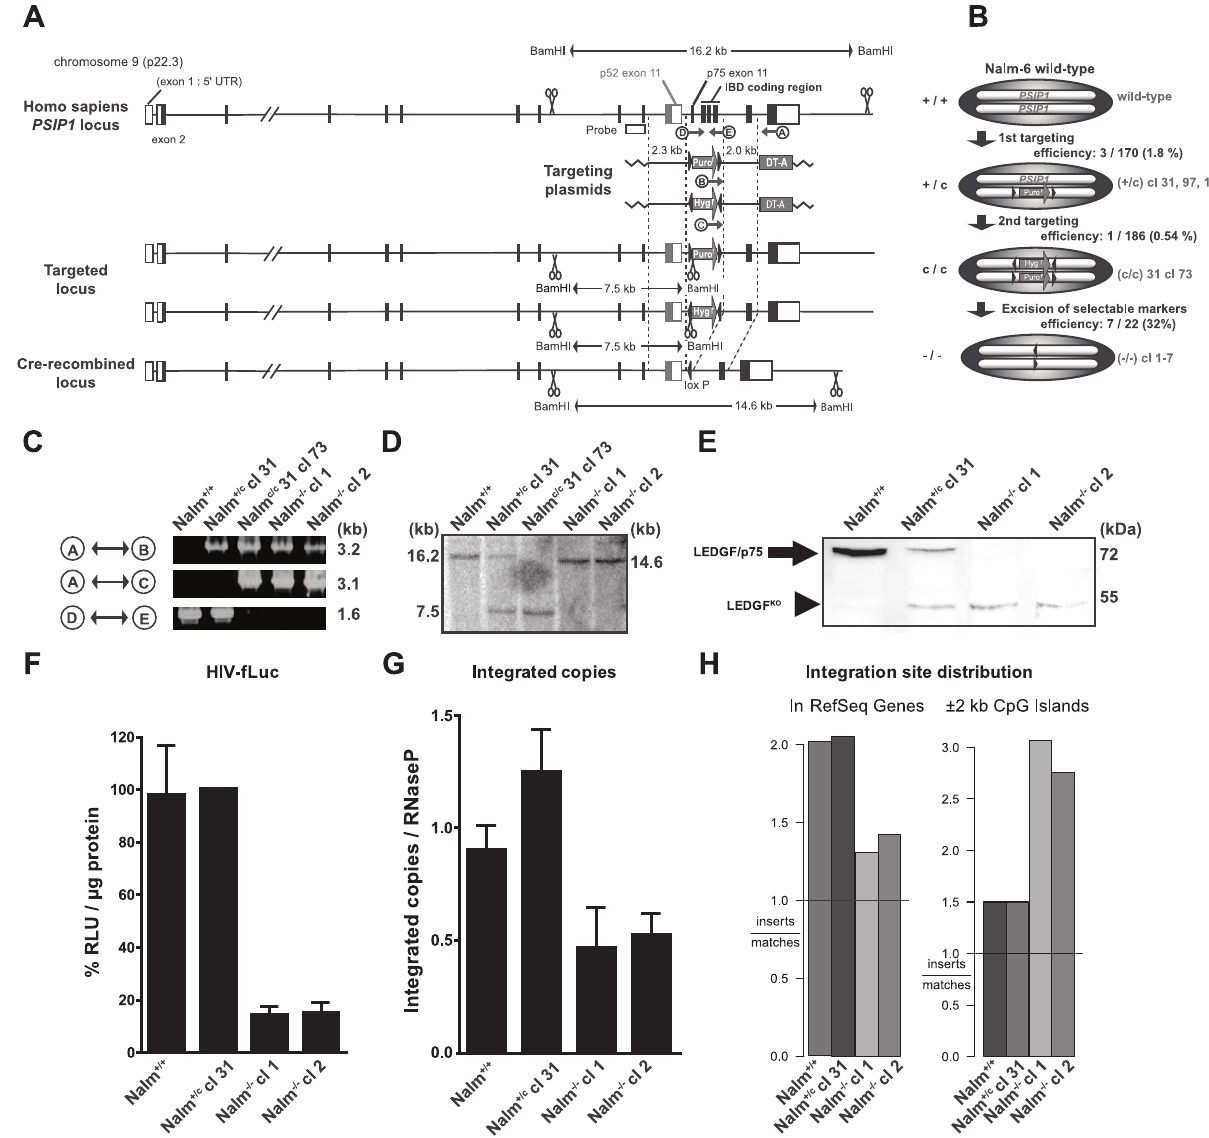
Figure 1. Generation and validation of human LEDGF/p75 KO cell line. (A) Scheme for PSIP1 gene targeting by homologous recombination. The 2.3 and 2.0 kb arm indicated on the targeting plasmids enable homologous recombination and harbor a puromycin (Puro r ) or hygromycin B resistance (Hyg r ) cassette (c) flanked by loxP sites (arrows). Exon 11 of p52 and p75 are indicated separately as well as the IBD coding region. BamHI restriction sites are indicated (scissors). DT-A denotes the gene encoding for Diphteria toxin A. (B) Schematic overview of KO and intermediates: Nalm- 6 wild-type (Nalm + / + ) contains 2 PSIP1 genes; Nalm + /c clones (cl) 31, 97, 147, contain a puromycin resistance cassette in one allele; Nalm c/c 31 cl 73, contains both a puromycin and a hygromycin B resistance cassette; after CRE-mediated excision cl 1-7 are generated and termed Nalm 2 / 2 . (C) Genomic PCR on DNA from different clones. Primer binding sites are indicated in panel A (see also Table S2). Indicated bands confirm amplification of a 1.6 kb fragment by primers D and E in full length PSIP1 as shown in Nalm + /c and Nalm + / + , but not in Nalm c/c and Nalm 2 / 2 cl 1. (D) Southern blot on genomic DNA after BamHI digestion. Probe and restriction sites are indicated in panel A. Intact PSIP1 generates a 16.2 kb fragment. After insertion of a resistance cassette a 7.5 kb fragment is generated, after CRE-mediated excision a 14.6 kb fragment is formed indicating KO of a 1.6 kb fragment containing exon 11–14. (E) Western blot analysis for LEDGF protein of whole cell extracts. Marker heights (right), LEDGF/p75 (arrow) and LEDGF KO (arrowhead) are indicated. (F) Nalm-6 cells were transduced with HIV-fLuc. Luciferase expression is shown as percentage relative light units (RLU) per m g protein as compared to Nalm + /c cl 31. (G) In parallel, the number of integrated proviral copies was evaluated for HIV-fLuc. Following transduction, cells were grown for at least 10 days to eliminate non-integrated viral DNA and analyzed by quantitative PCR. (H) HIV-1 integration site distribution analysis. Left panel shows relative number of experimentally derived HIV-1 integration events in genes according to the RefSeq annotation, versus computationally generated matched random control (MRC). The right panel shows integration events occurring 6 2 kb around CpG islands as compared with MRC. Average 6 standard deviations are shown from experiments performed at least in triplicate. doi:10.1371/journal.ppat.1002558.g001 to the remaining minute amounts of LEDGF/p75 [5,6,20]. infection in the absence of LEDGF/p75 could not be tested. To Although single round viral vector transduction was severely test HIV-1 replication, we introduced the CD4 receptor into the reduced in LEDGF KO MEFs [11,17,21], spreading HIV-1 Nalm-6 cells that express CXCR4 [31], a co-receptor for HIV-1